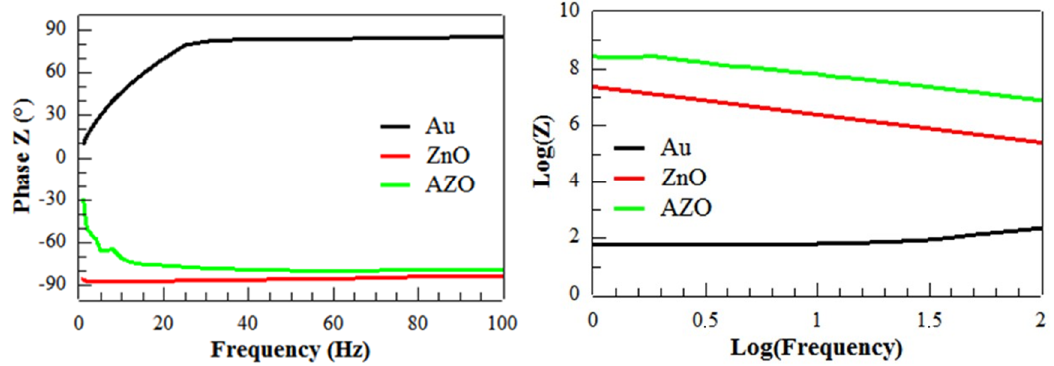
Figure 8. Curves extracted from impedance measurements showing ( a ) the log(Z) vs. log(frequency) and ( b ) the Z phase vs. the frequency for PENGs made from ZnO NWs grown on Au, ZnO and AZO seed layers.